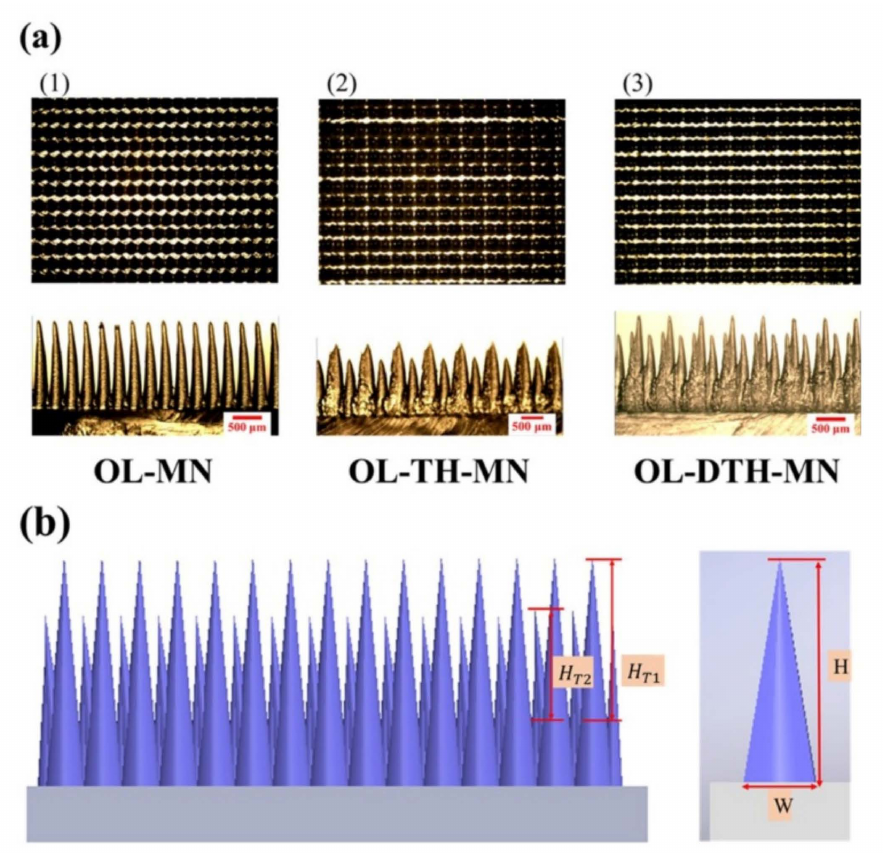
Figure 30. ( a ) OM of the top-view PMMA master mold and the cross-sectional overlapped two-height microneedle PDMS. ( b ) Schematic dimension of OL-TH-MN and